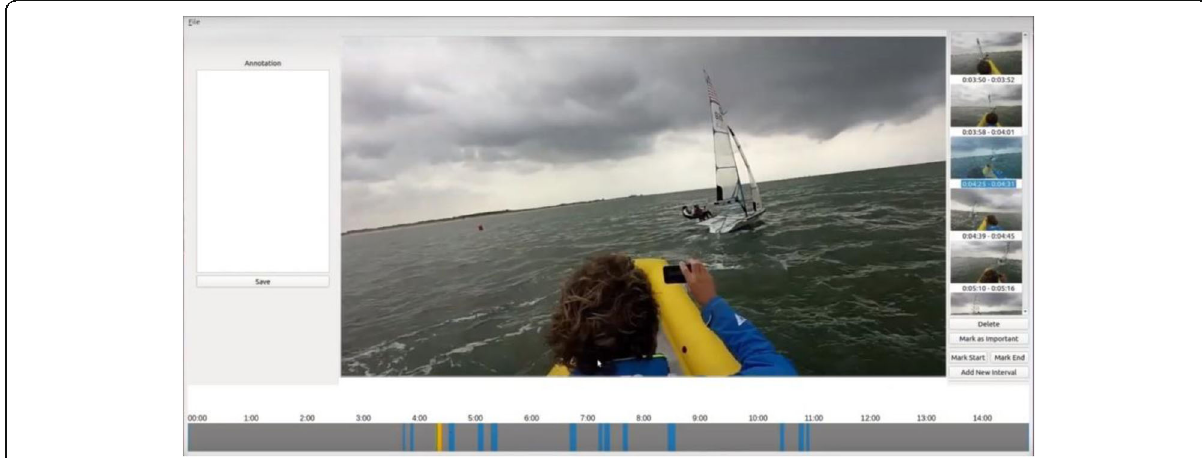
Fig. 6 The implemented sailing maneuver analysis pipeline to locate maneuvers in a video and visualize these intervals. The timeline (bottom part) shows in blue the detected maneuvers and in orange the current selected instant in the main